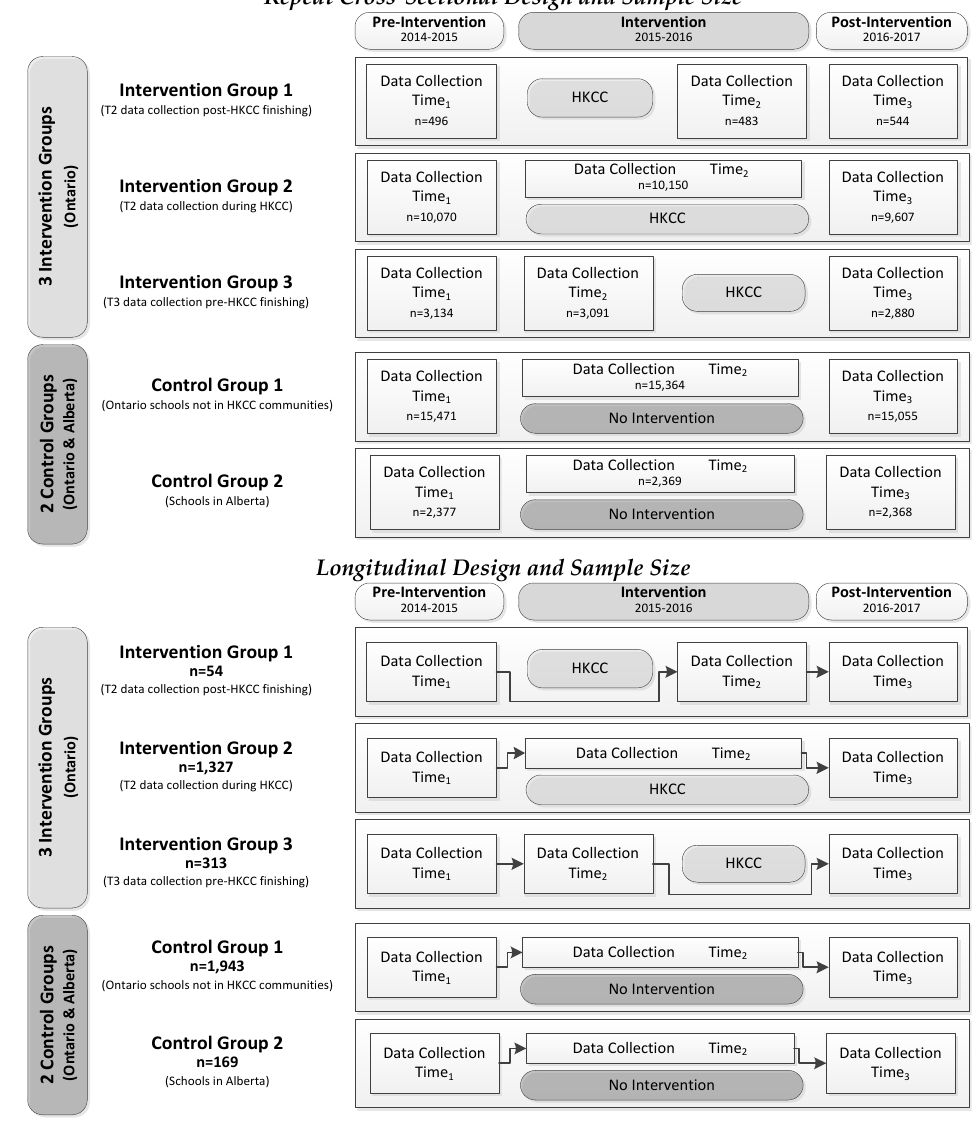
Figure 1. Student-level sample size for the repeat cross-sectional and longitudinal samples in the interrupted time series quasi-experimental design evaluating the impact of the Healthy Kids Community Challenge (HKCC) using data from